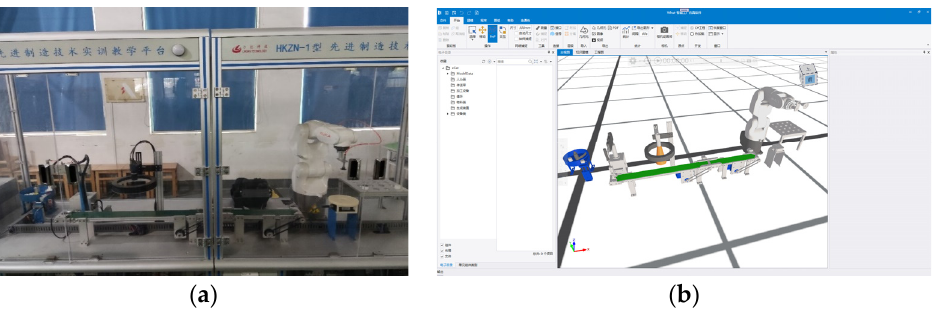
Figure 6. Practical teaching platform: ( a ) physical entities; ( b ) digital twin models.